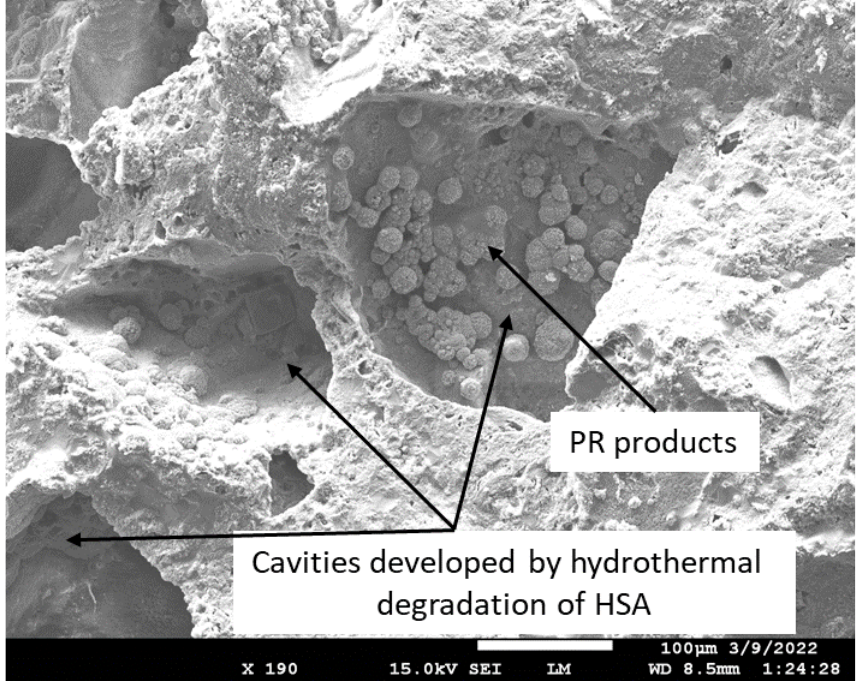
Figure 16. Photomicrograph of freshly fractured 250 °C-autoclaved Ca/HSA cement.